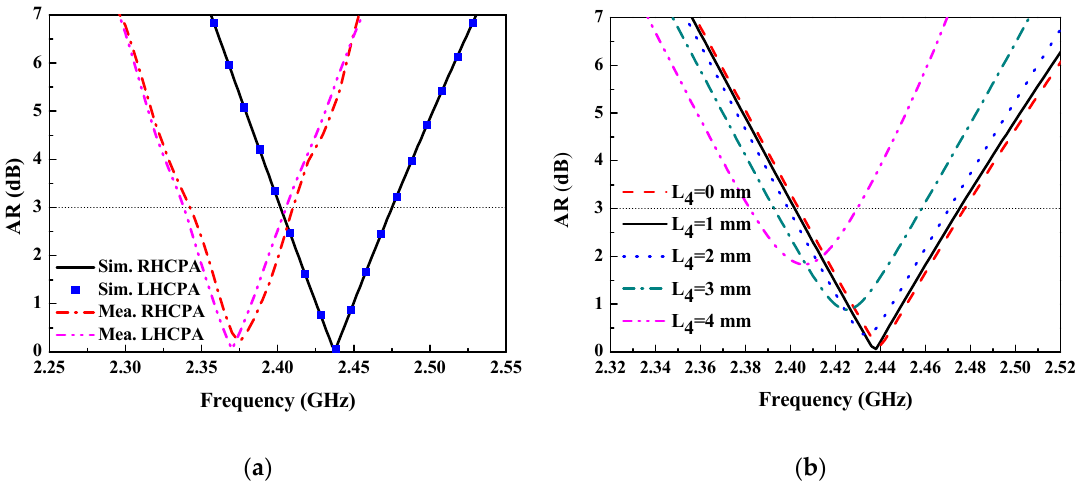
Figure 8. ( a ) Simulated and measured AR of the RHCPA and the LHCPA versus frequency; ( b ) AR optimization with varied short stub length corresponding to the RHCPA.